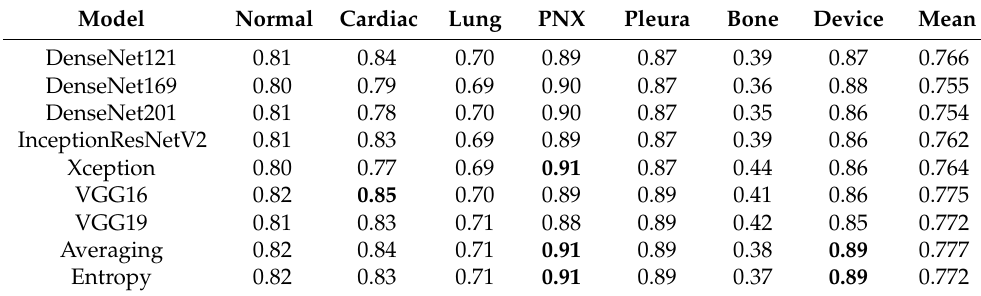
Table 5. CNN results with pretrained networks without retraining in terms of AUC. Each column represents an HUM-CXR label. We report the results for each network and for the two ensembling strategies. The best results for each class and average are highlighted in bold. Model Normal Cardiac Lung PNX Pleura Bone Device